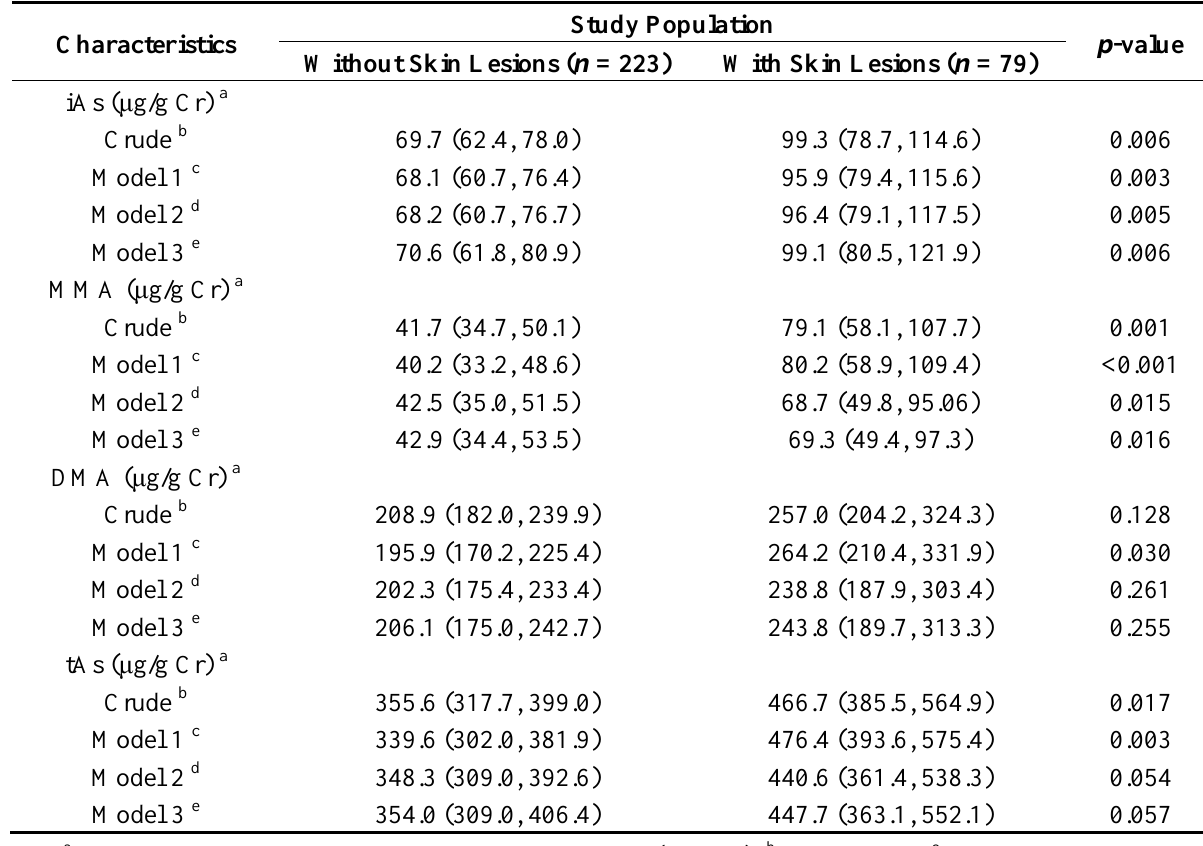
Table 3. Differences of adjusted means of urinary arsenic species between subjects with and without skin lesions.